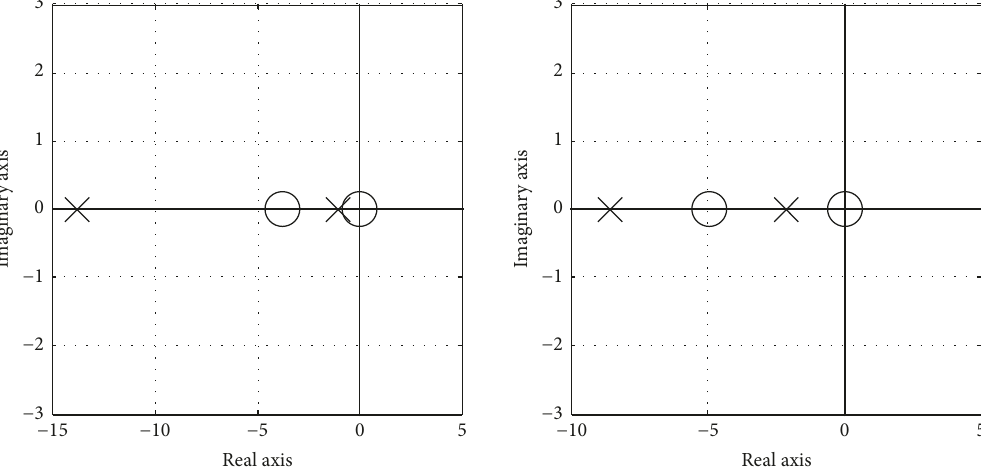
When gain perturbation arises in controller, the two poles of the robust nonfragile H ∞ controller are distributed in the left plane gain perturbation left half plane, while the two poles of the conventional robust H ∞ controller are distributed in the right planes and the controller is